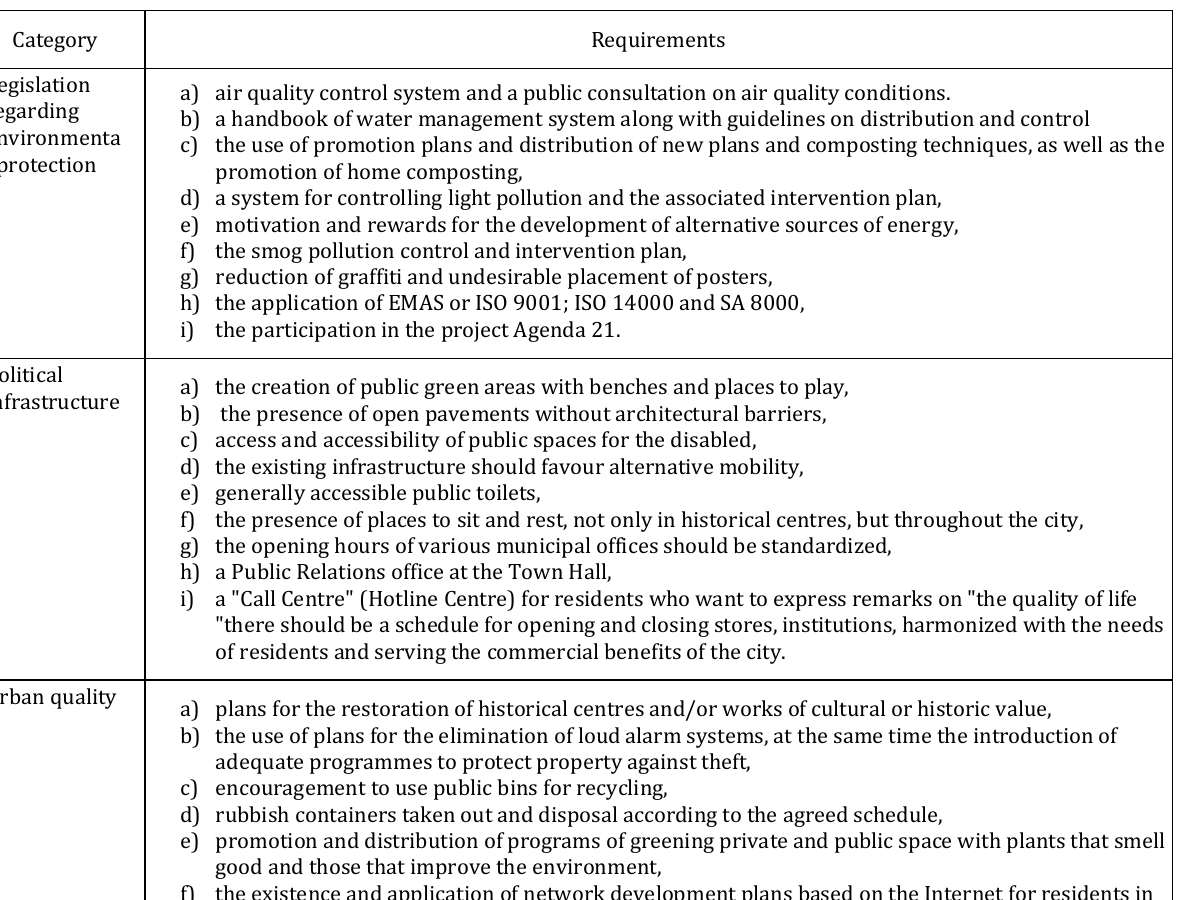
Table 1. Requirements for the Slow City movement